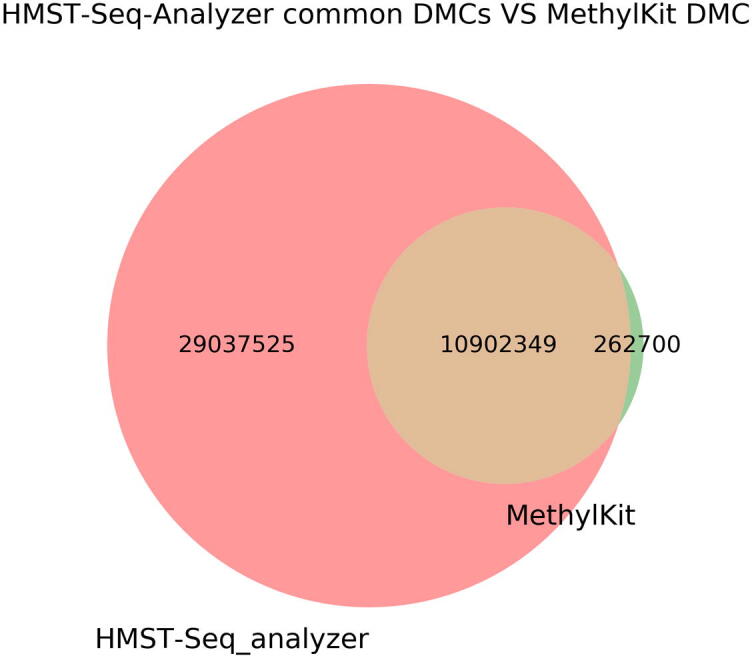
Whole-genome DMC comparison for WGBS (HMST-Seq-Analyzer VS MethylKit). Number of genome-wide DMCs predicted by HMST-Seq and MethylKit are shown in figure. Unique DMCs predicted by HMST-Seq-Analyzer are represented in Pink, by MethylKit in green and overlapping in brown, respectively. Both HMST-Seq-Analyzer and MethylKit were run in default parameters. Here, ~98% of the DMCs identified by MethylKit are overlapping with DMCs predicted by HMST-Seq-Analyzer. (For interpretation of the references to colour in this figure legend, the reader is referred to the web version of this article.)